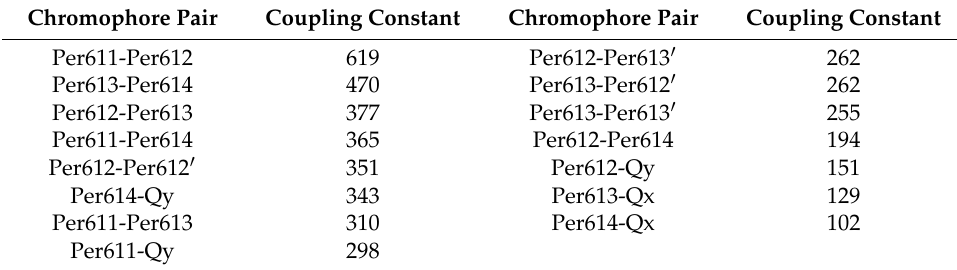
Table 4. Inter-chromophore coupling constants in PCP for interactions larger than 100 cm − 1